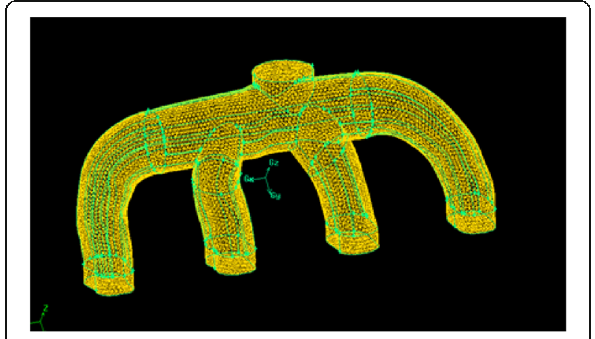
Fig. 3 Intake manifold GAMBIT